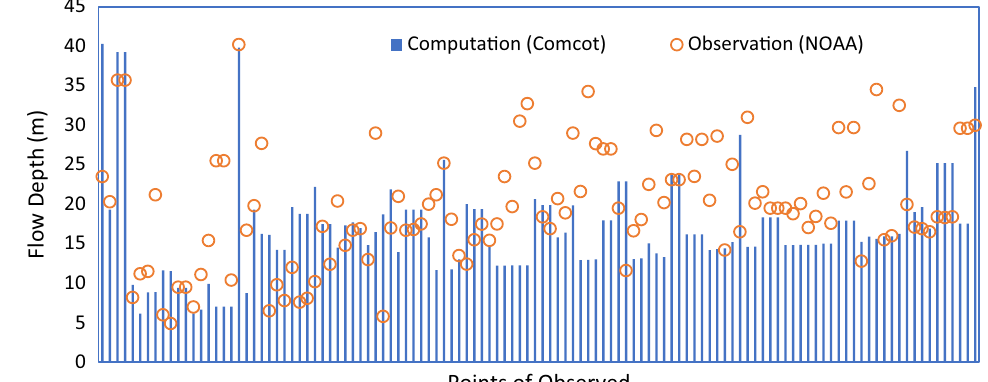
Fig. 5 Computation and observed flow depth from NOAA